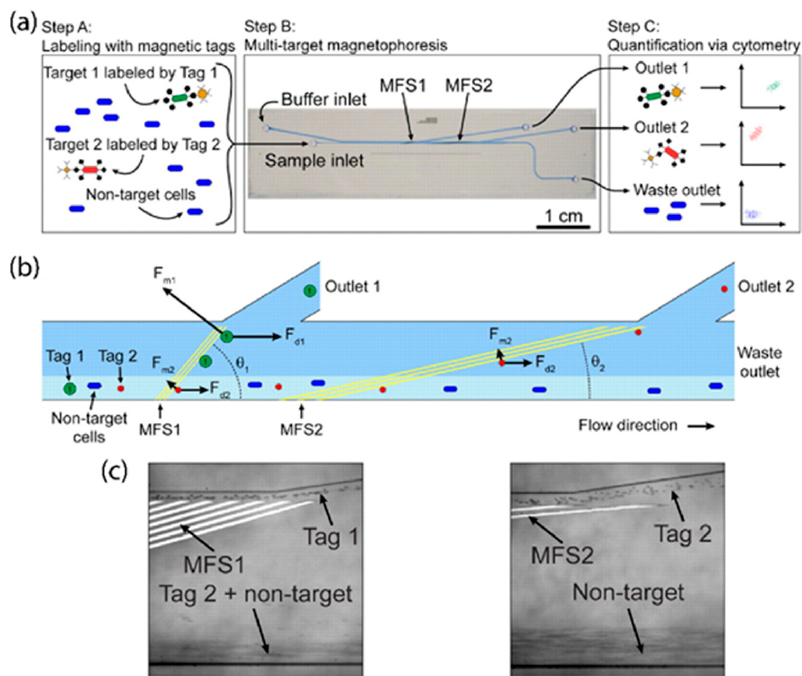
Figure 11. Multiplexed magnetophoretic sorting structure. ( a ) Operational summary of the device. ( b ) Illustration of the forces acting on the cells across the device. ( c ) Microscopic images of multiplexed sorting during operation. Reproduced with permission [88]. Copyright 2008 PNAS.